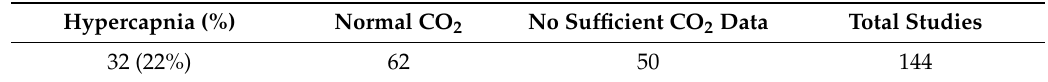
Table 4. Hypoventilation frequency.